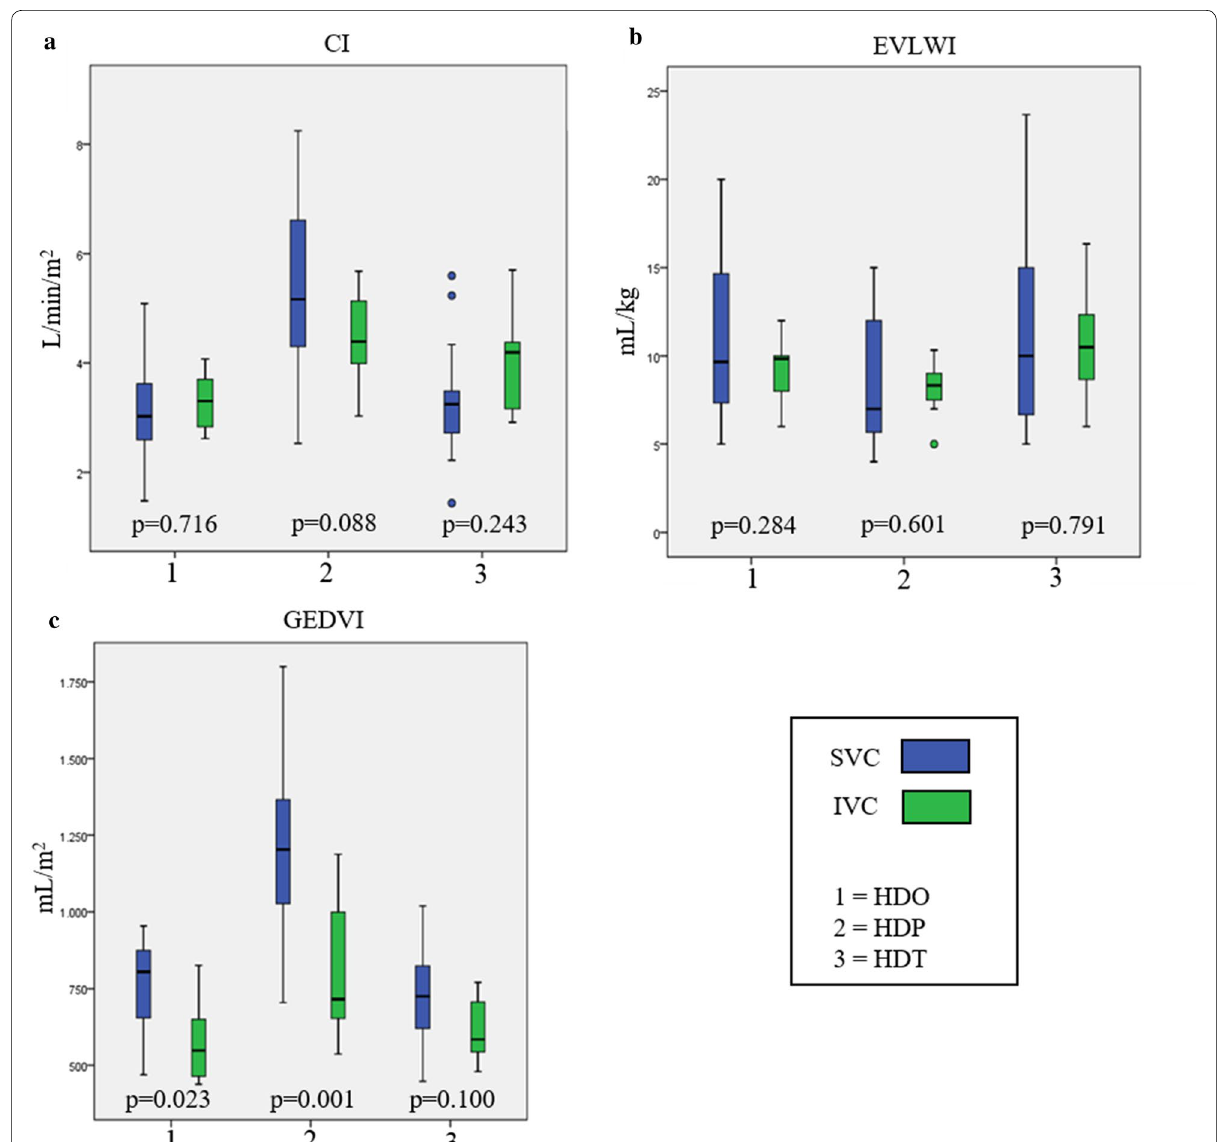
Fig. 2 Boxplots CI, EVLWI, GEDVI. Shown are the values (median/25. and 75. percentile) for the parameters cardiac index (CI) ( a ), extravascular lung water index (EVLWI) ( b ) and global end-diastolic volume index (GEDVI) ( c ) at ongoing HD (HDO), paused HD (HDP) and terminated HD (HDT) for measurements via a catheter in the superior vena cava (SVC) or inferior vena cava (IVC). The given p values indicate the differences between SVC and